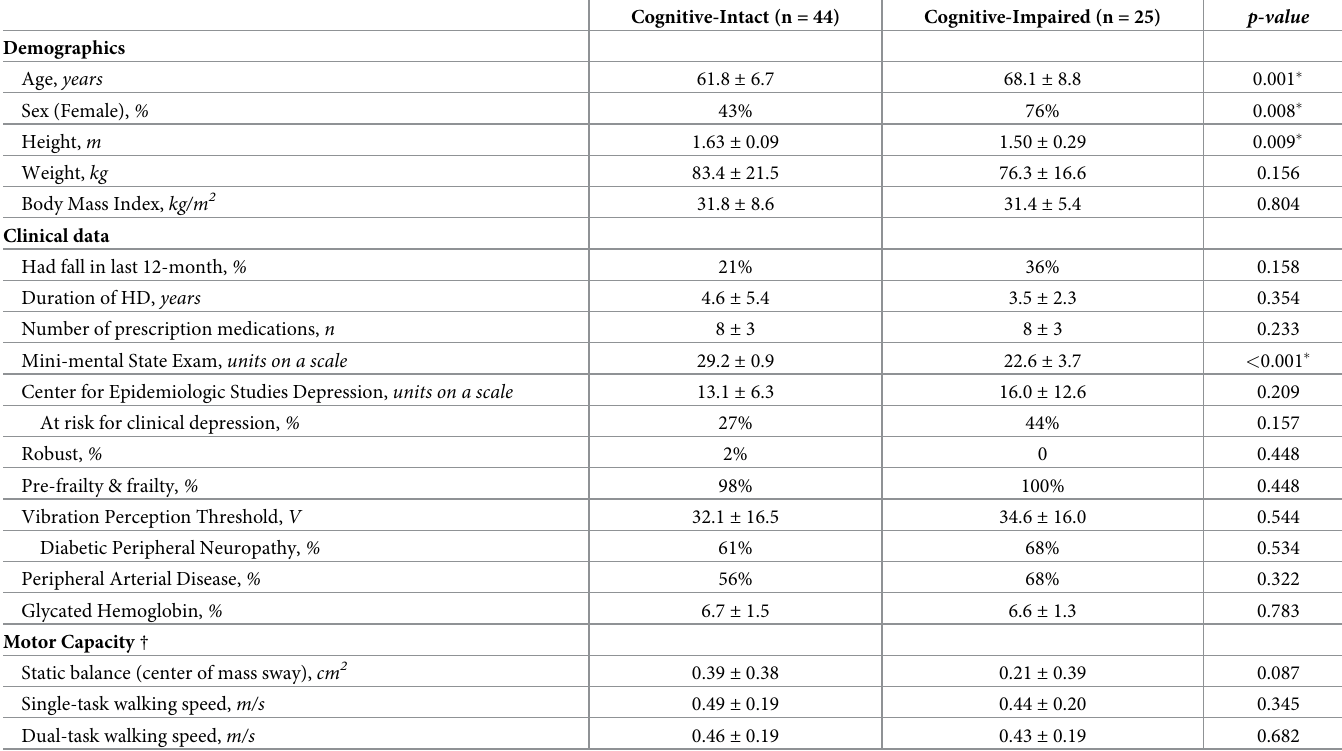
Table 1. Demographics, clinical data, and motor capacity of the study